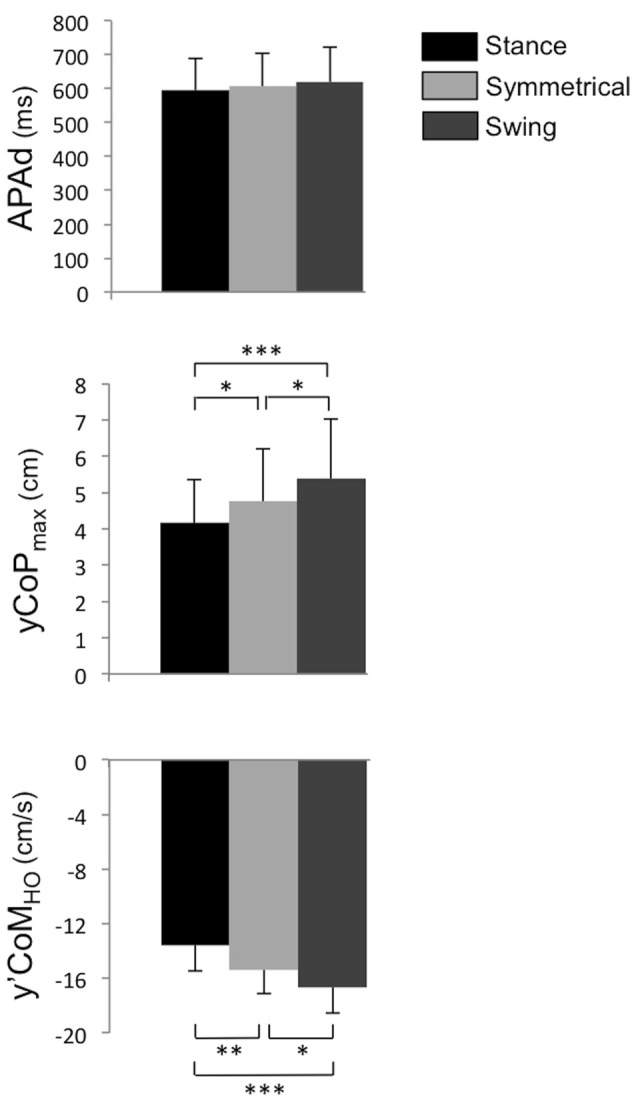
Mean of temporo-spatial features of APA under the Stance, Symmetrical and Swing conditions. APAd: APA duration; yCoPmax: peak of mediolateral CoP shift towards the swing leg during APA. y’CoMHO: mediolateral CoM velocity at heel-off. Negative values indicate a displacement or velocity directed towards the stance leg. *,**,***Significant difference with P < 0.05, P < 0.01 and P < 0.001, respectively.